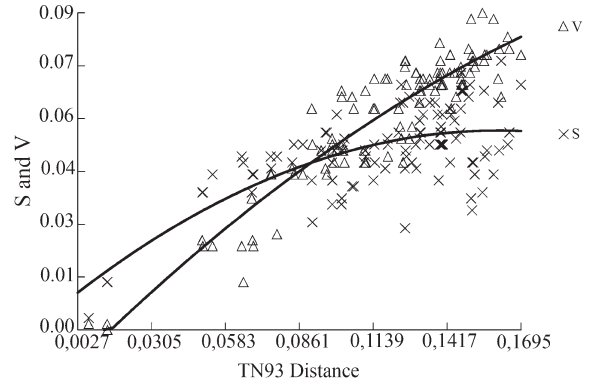
Figure 2 - Plot of the number of transitions (S) and transversions (V) vs. divergence among partial sequences of the mitochondrial cytochrome oxidase subunit I ( COI ) gene. The curve (S) indicates the presence of satu- ration in the